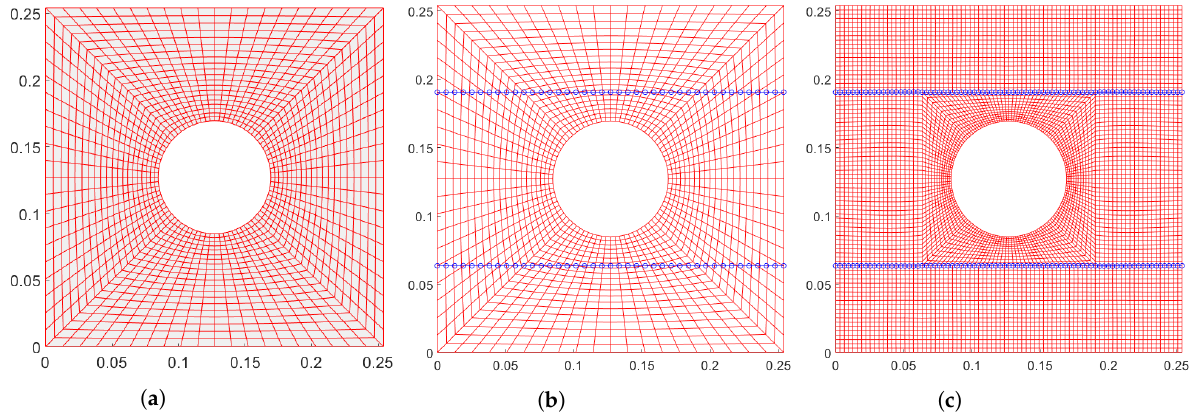
Figure 6. Finite element models of a stiffened VAT laminated plate with a central cutout; stiffener mesh (in blue). ( a ) Mesh of the plate with a cutout; ( b ) present finite element model; ( c ) NASTRAN finite element